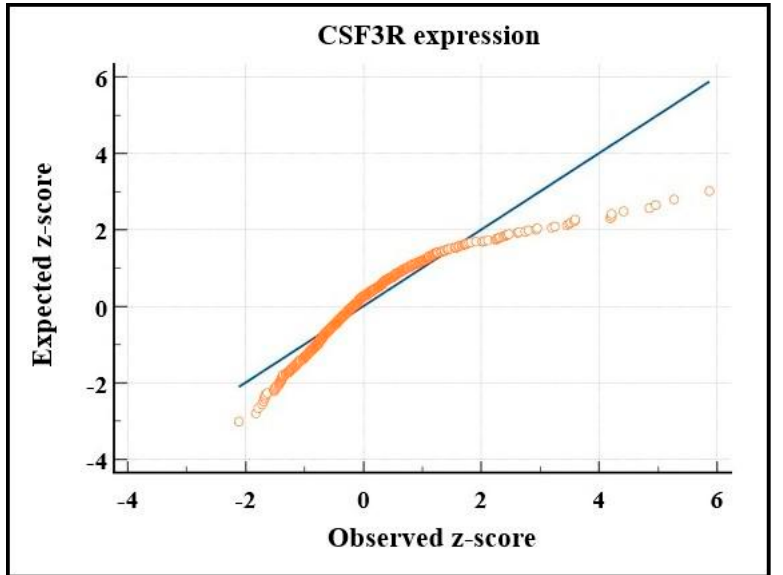
Figure 1. CSF3R expression distribution pattern. The straight line represents the reference for normal distribution, while the orange marks represent the gene expression data. Source: the authors.